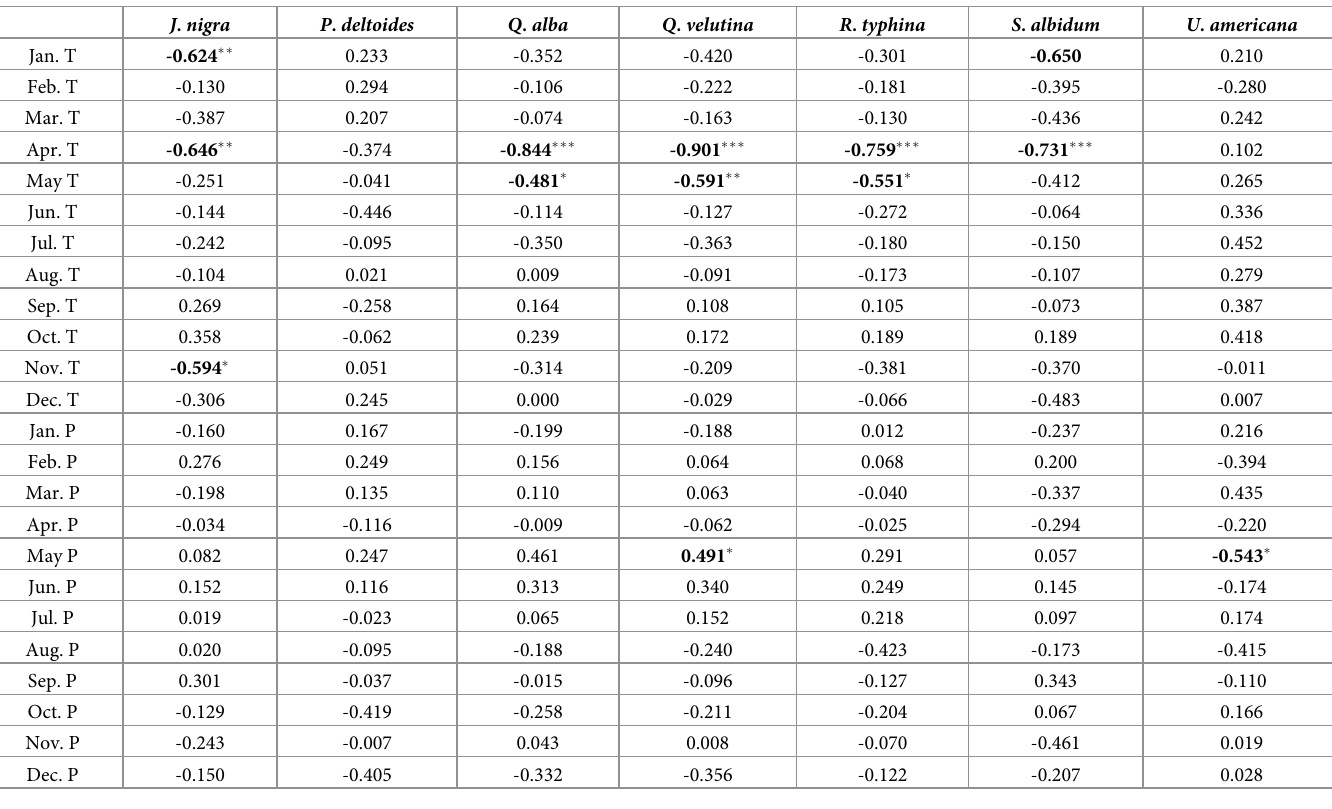
Table 1. Correlation coefficients for budburst DOY with mean monthly temperature (oC) and total monthly precipitation (cm) for the month of and 11 months preceding budburst in the seven focal